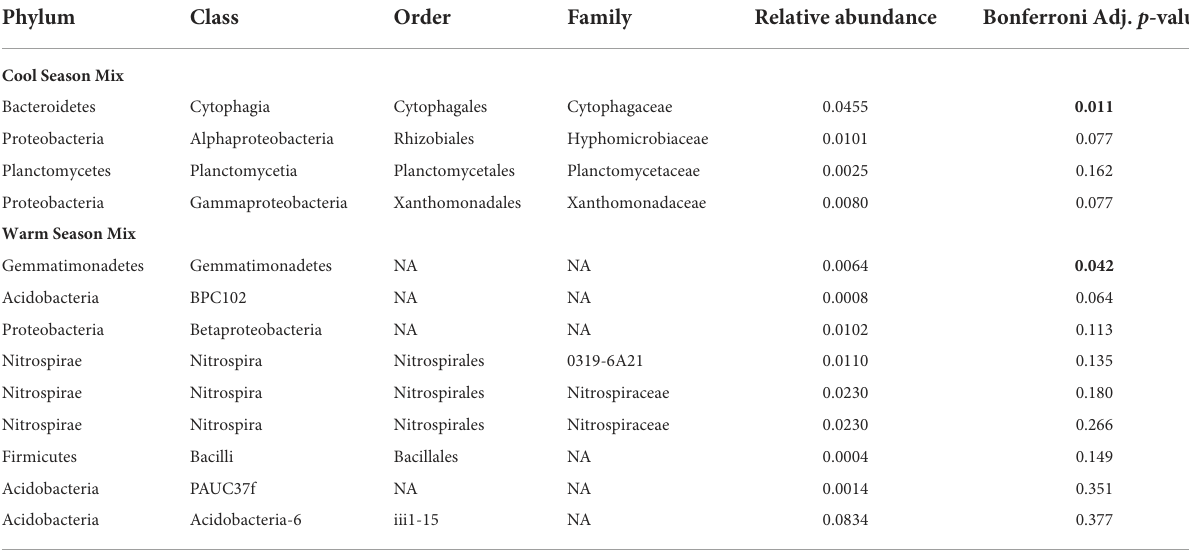
TABLE 4 Indicator species analysis (ISA) based on taxonomic assignment with the Silva 132 database.